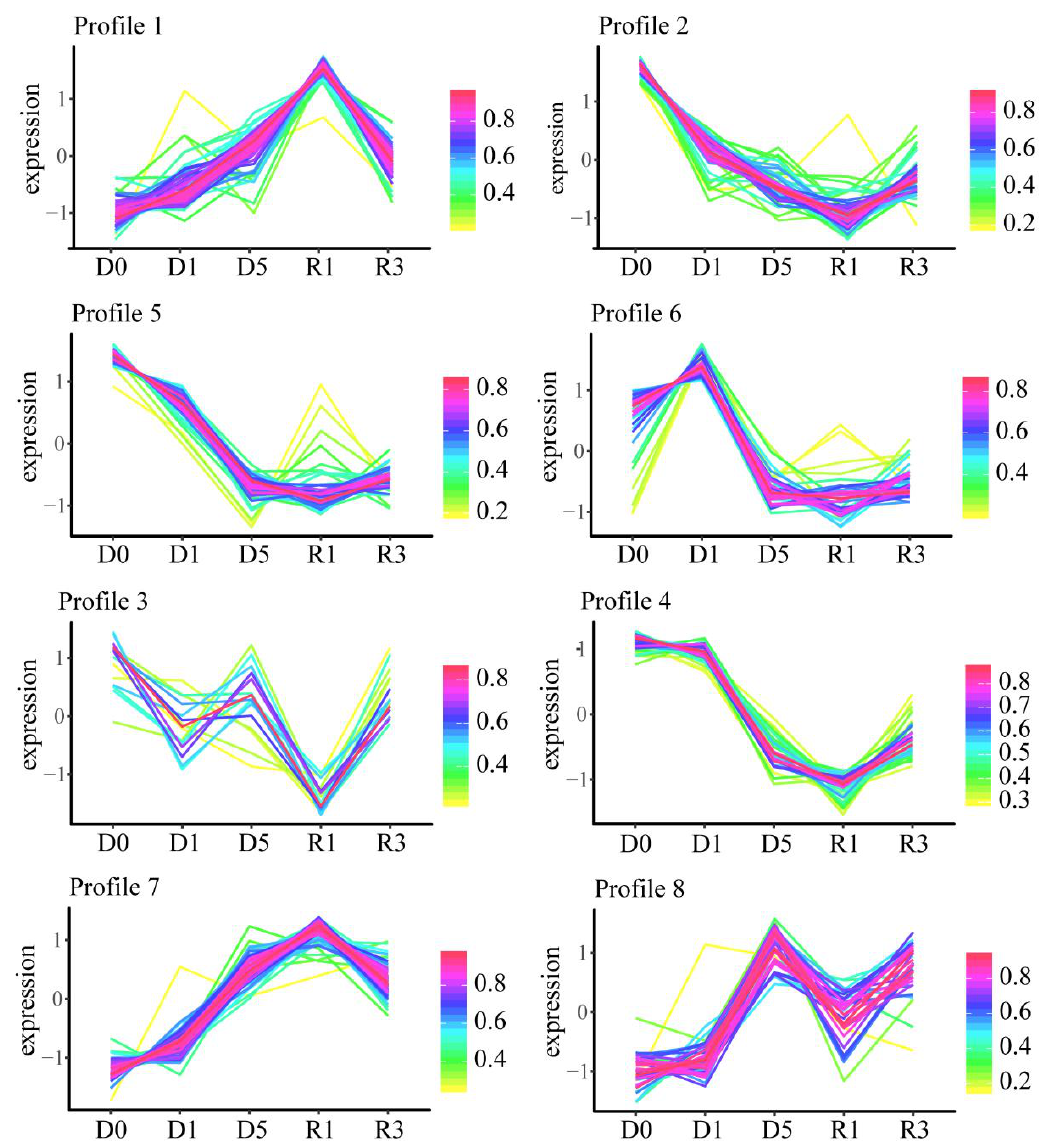
Figure 3. Differential accumulation patterns of total differentially expressed proteins.